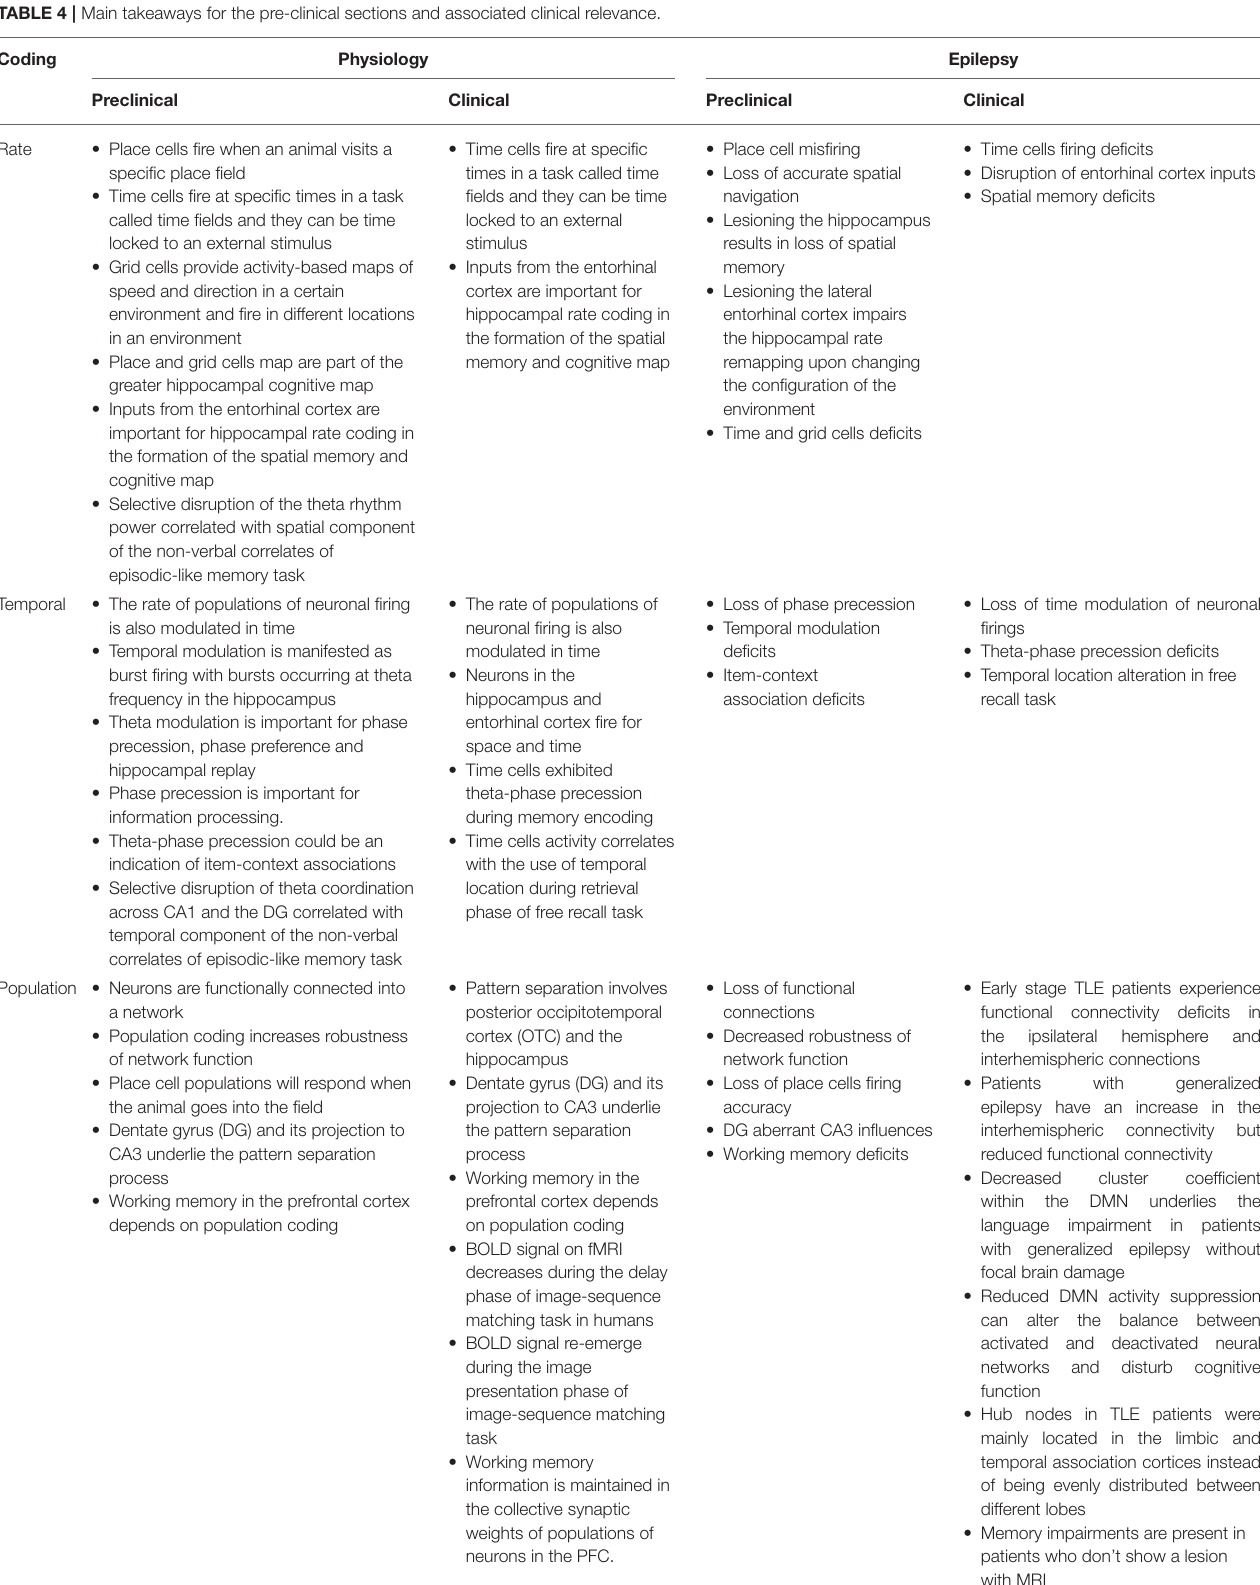
TABLE 4 | Main takeaways for the pre-clinical sections and associated clinical